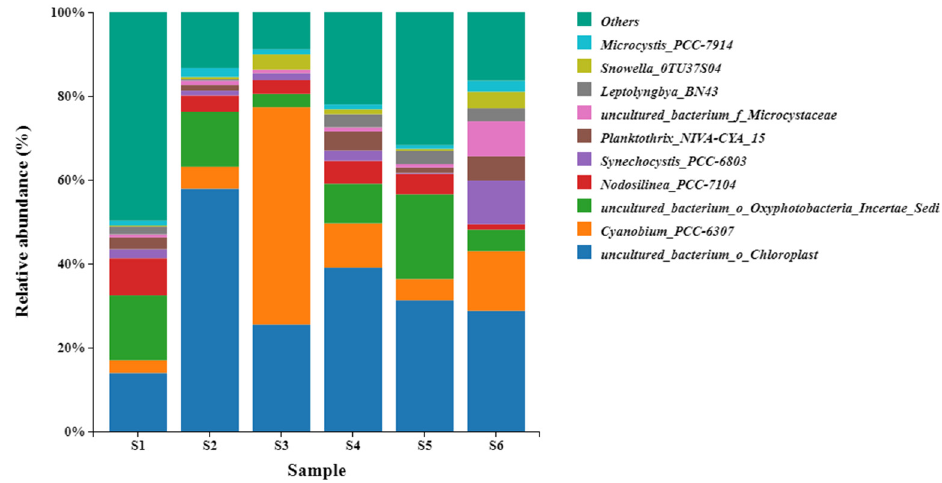
Figure 4. Relative abundance of soil cyanobacteria in different areas of Jilin Province.